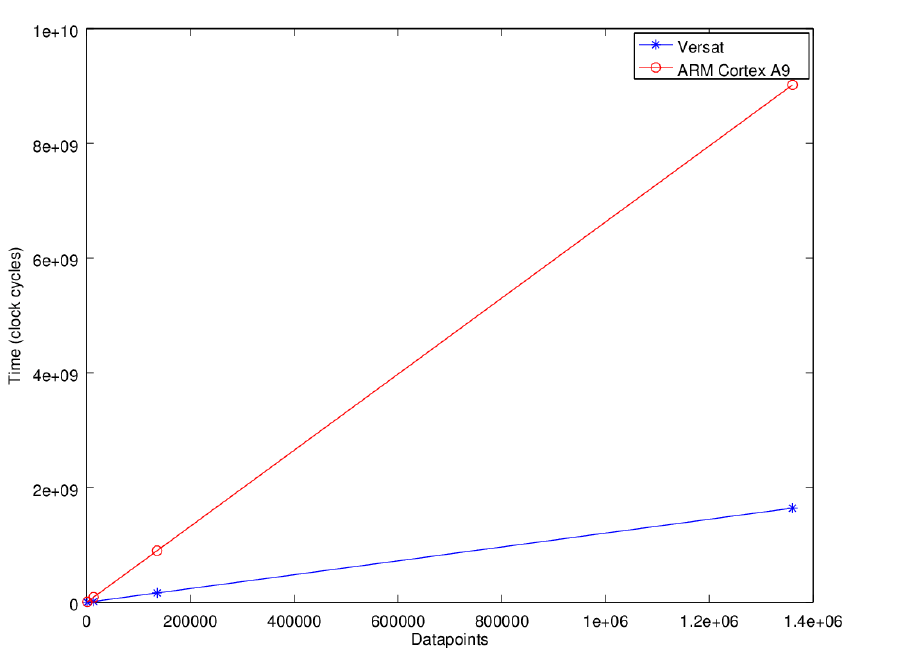
Figure 11. K-Means: iteration time vs. number of datapoints, for 30 dimensions and 34 centroids.